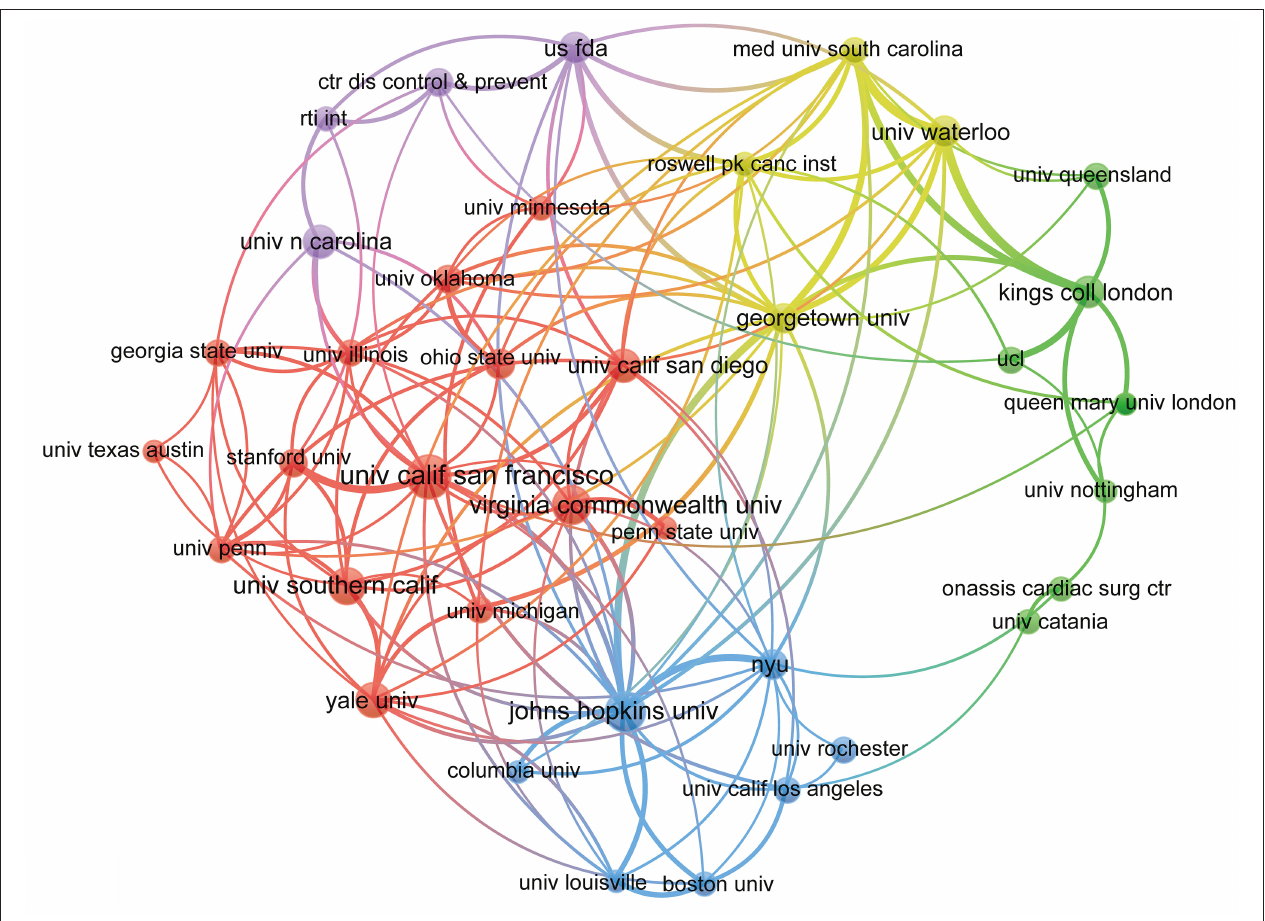
FIGURE 3 | The network map of institutions for e-cigarettes